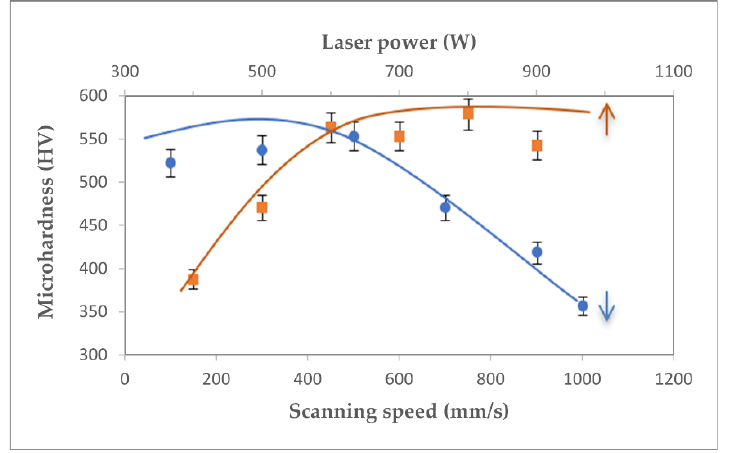
Figure 9. Effect of laser power and laser scanning velocity on microhardness of W-5Ni-2Fe samples.